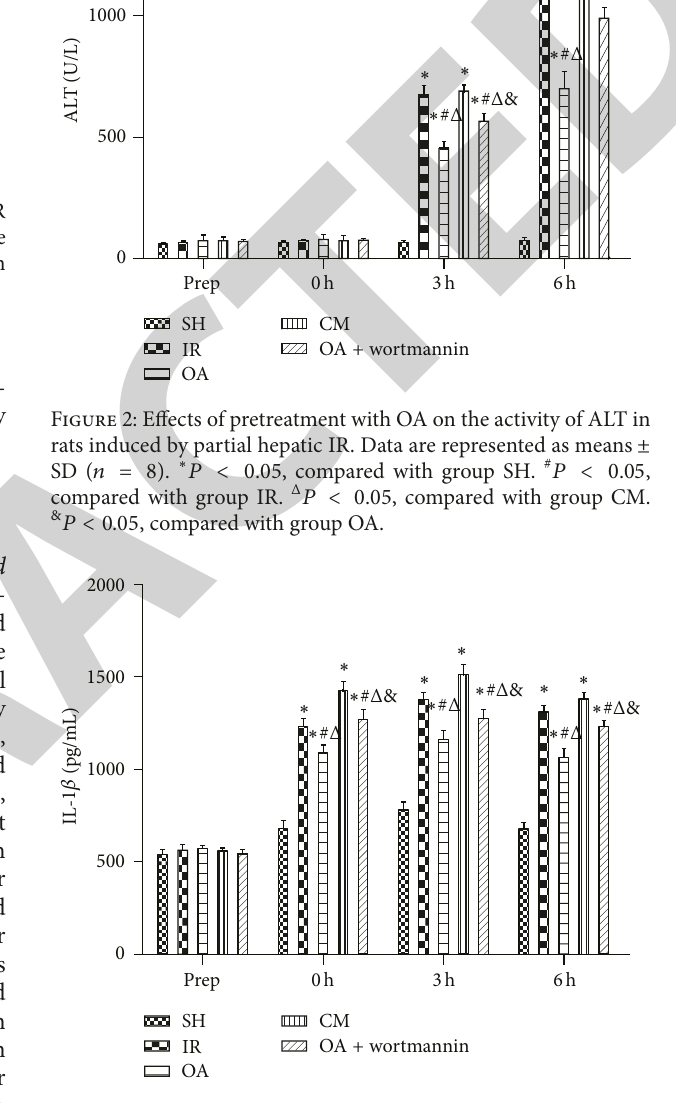
Figure 3: Effects of pretreatment with OA on the release of IL-1 𝛽 in rats induced by partial hepatic IR. Data are represented as means ± SD ( 𝑛 = 8 ). ∗ 𝑃 < 0.05 , compared with group SH. # 𝑃 < 0.05 , compared with group IR. Δ 𝑃 < 0.05 , compared with group CM. & 𝑃 < 0.05 , compared with group